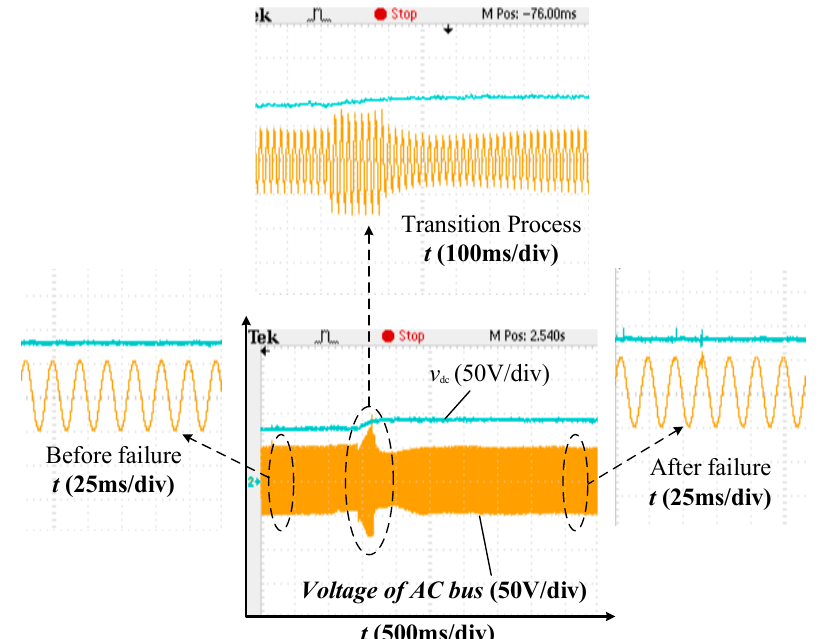
Figure 20. Experimental waveforms of SPEER switching from grid-connected to isolated network when isolated island occurs.